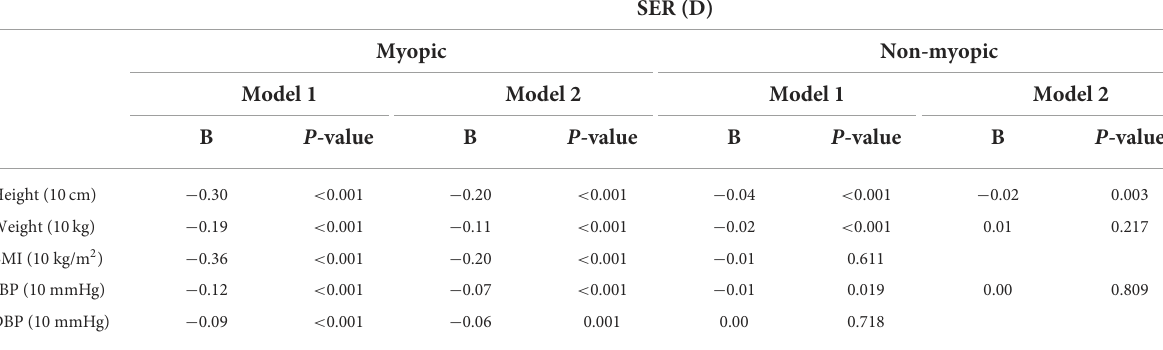
TABLE 4 Multiple linear regression models of SER by height, weight, BMI, SBP, and DBP for myopic and non-myopic children